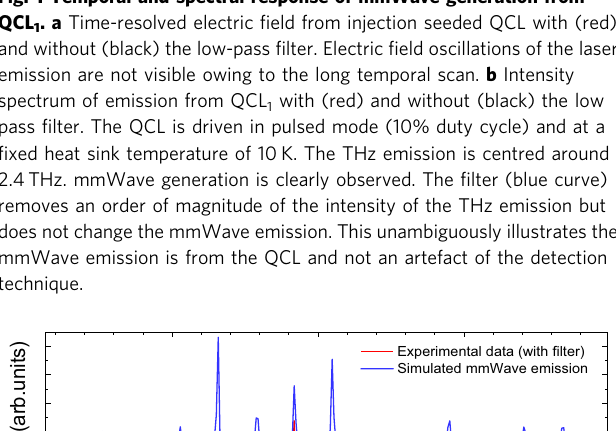
The transmission spectrum is shown in Fig. 1b (blue dotted curve). Although the THz signal intensity is attenuated by more than one order of magnitude, the mmWave lines remain the same, demonstrating that the emission originates from the QCL.